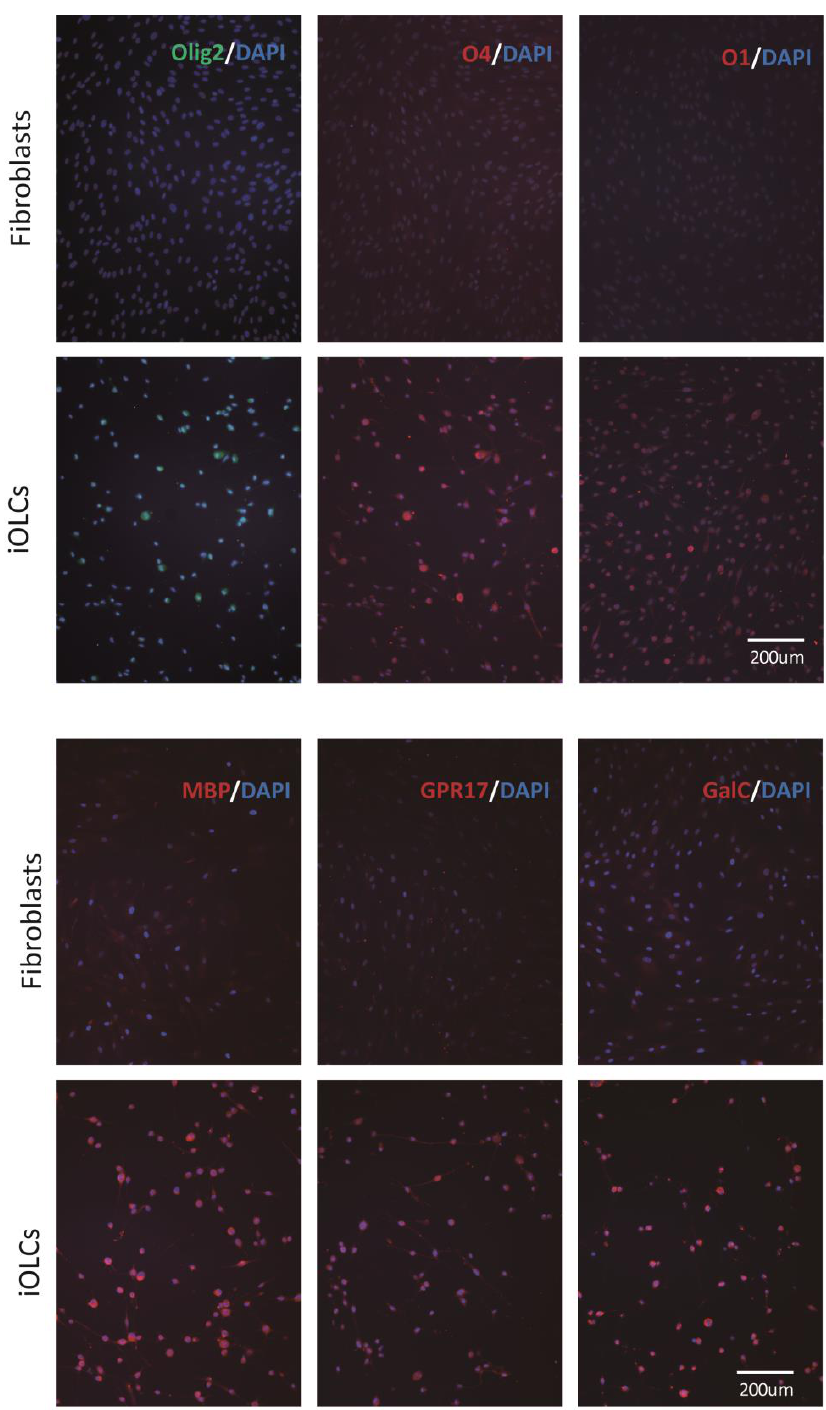
Figure 3. Expression of oligodendrocyte markers observed by immunofluorescence on iOLCs induced with four chemicals. iOLCs induced by the VYSF cocktail are compared with the solvent control (fibroblasts) group. To start, 1 × 10 4 fibroblasts were seeded in each well of 24-well plates; after two days of expansion, fibroblasts were treated with the VYSF cocktail. Data showing protein expression, including oligodendrocyte-specific transcription factor Olig2 (upper left, green); oligodendrocyte- specific surface antigens O4 (upper–middle, red) and O1 (upper right, red); and oligodendrocyte- specific markers MBP (bottom left, red), GPR17 (bottom–middle, red), and galactosylceramidase (bottom right, red). DAPI (blue) was used to stain nuclei. VYSF refers to valproic acid, Y27632, SU9516, and forskolin,